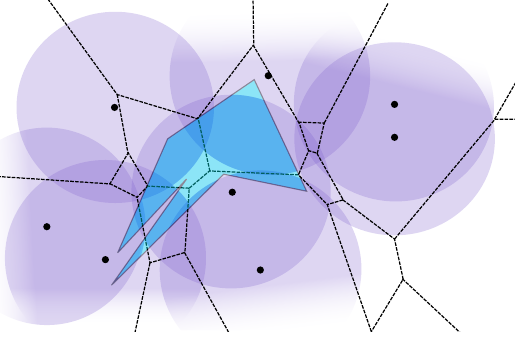
( S ) in a dashed line. The arrange- 2 ( S ) is shown in dark blue. 2